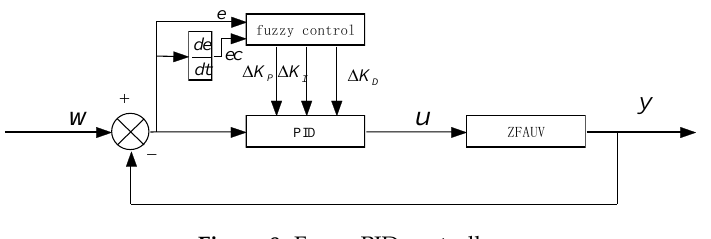
Figure 8. Fuzzy PID controller.